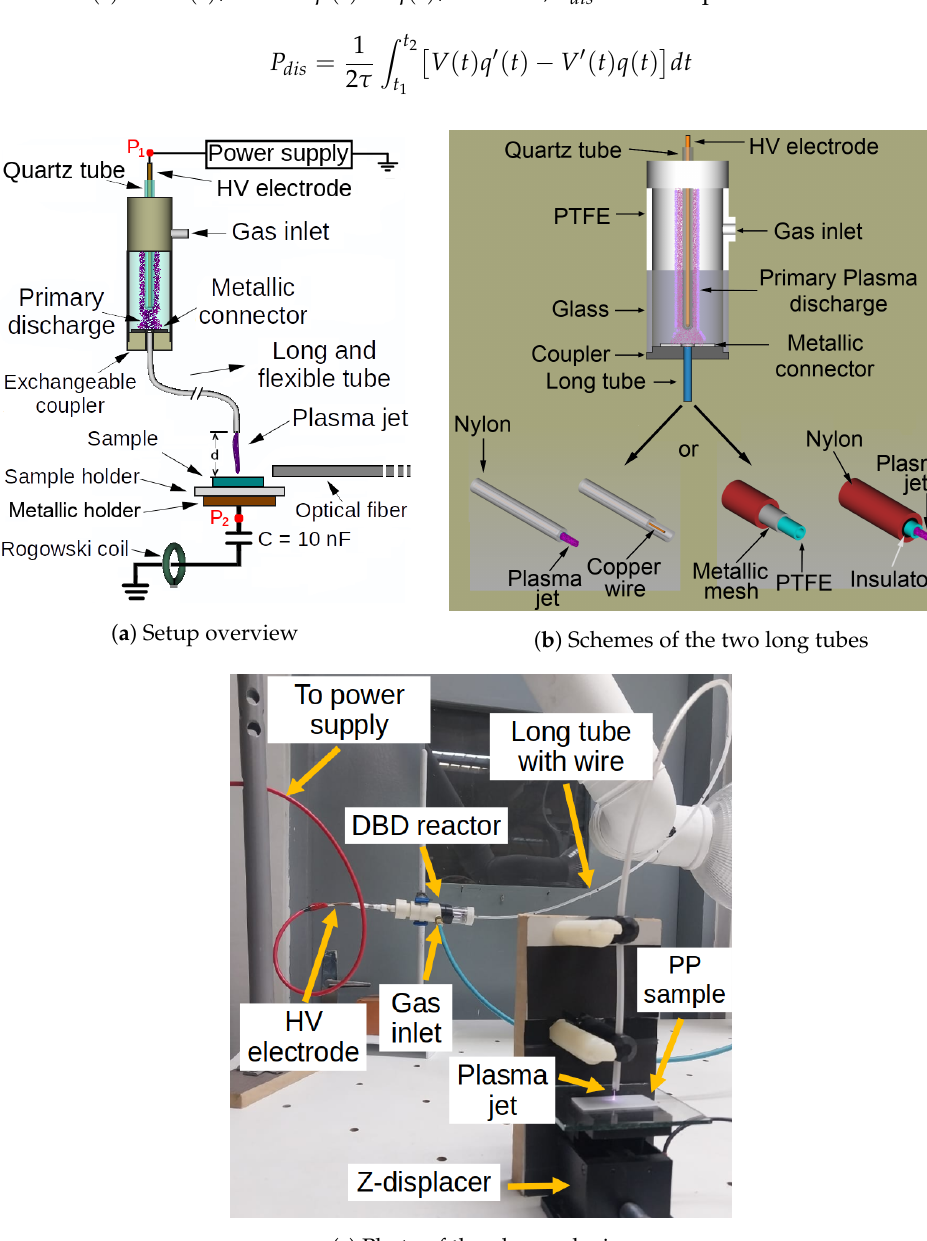
Figure 1. ( a ) Overview of the experimental setup. ( b ) Details of the two long tube configurations. ( c ) Photograph of the plasma device using the wire configuration, with the APPJ being applied on a PP